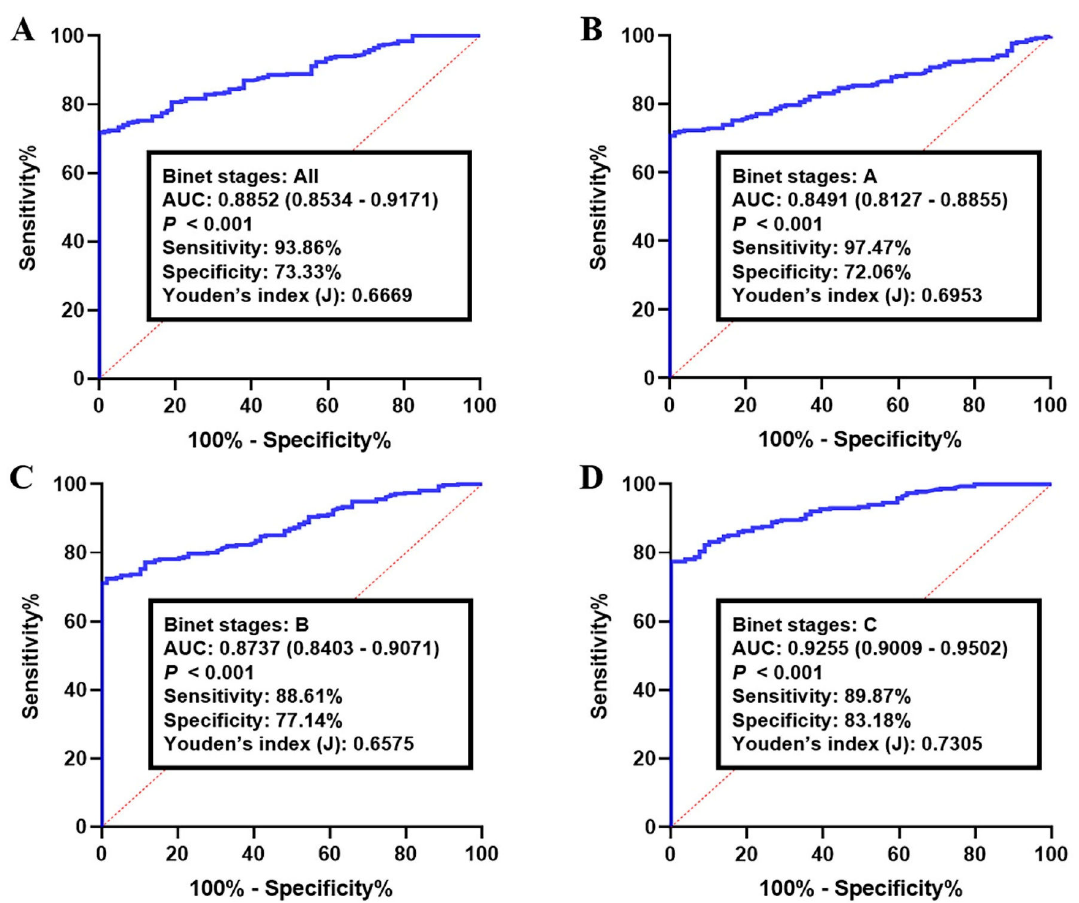
Figure 4. Receiver operating characteristics (ROC) curve analysis of the log it model with the cir- cKAT6A/circLNPEP/circMDM2/circMYH9 panel in the validation set II. The study group consisted of 251 CLLs and healthy B-lymphocytes. Using the optimal cutoff value as 0.7262, the diagnostic performance of circRNA panel for discriminating CLLs with ( A ) all Binet stages, ( B ) Binet stage A, ( C ) Binet stage B, and ( D ) Binet stage C from healthy samples were examined. Log it (p) of the model was 0.7262 + 0.7690 × CircKAT6A + 0.1786 × CircLNPEP − 0.2246 × CircMDM2 + 0.9938 ×